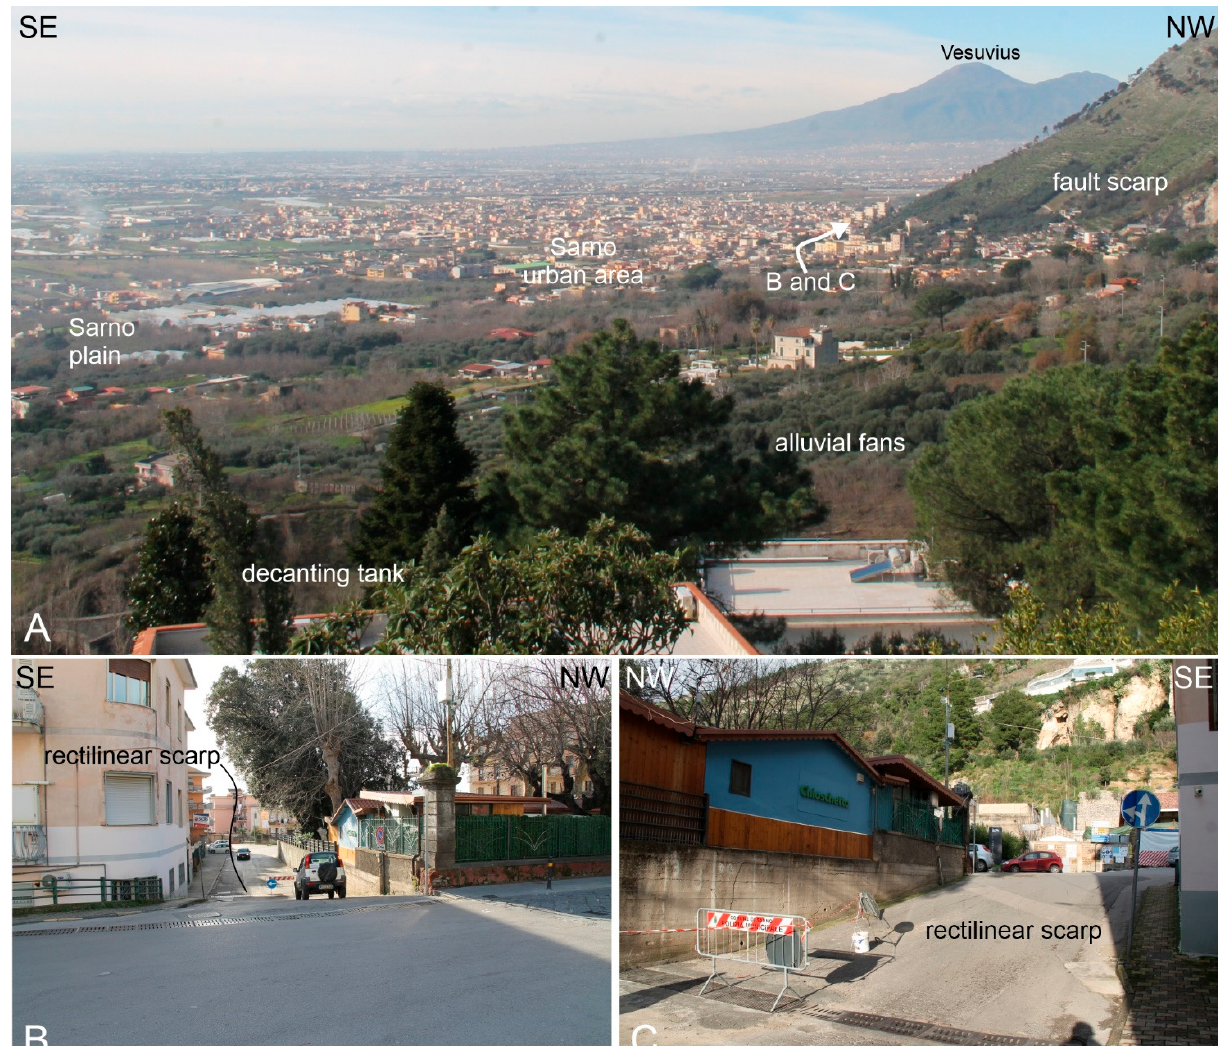
Figure 3 . ( A ) panoramic view of the Sarno plain from the Lavorate embayment. White arrow near Sarno town indicates location of the rectilinear scarp shown in insets B and C; a portion of the rectilinear scarp seen from footwall ( B ) and hanging wall ( C ) blocks.